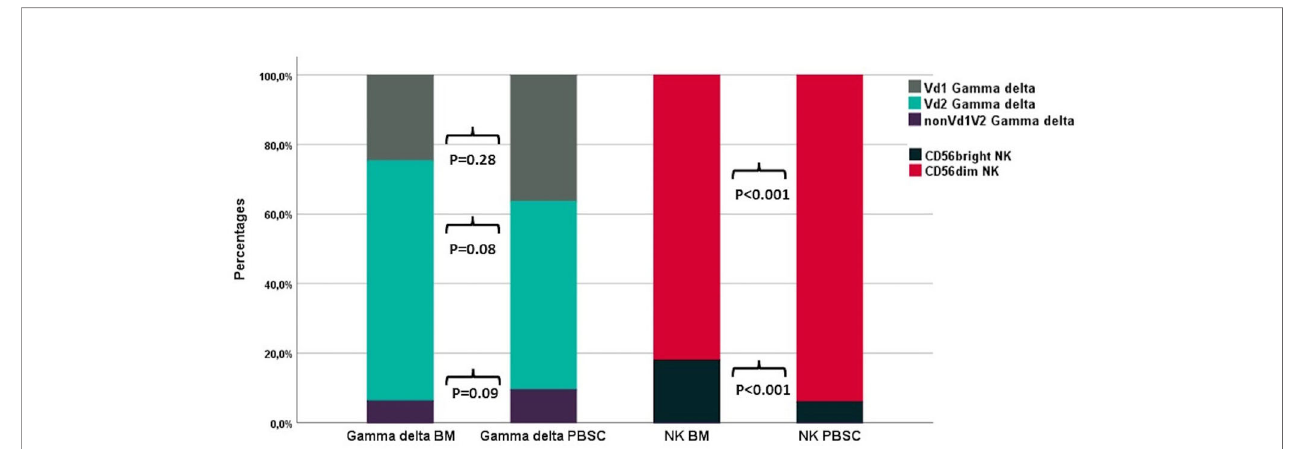
FIGURE 4 | The distribution of TCR gd and NK cell subsets in BM (n=14) and PBSC (n=17) grafts. P-values from the Mann-Whitney test. Each compartment is constructed by the use of median